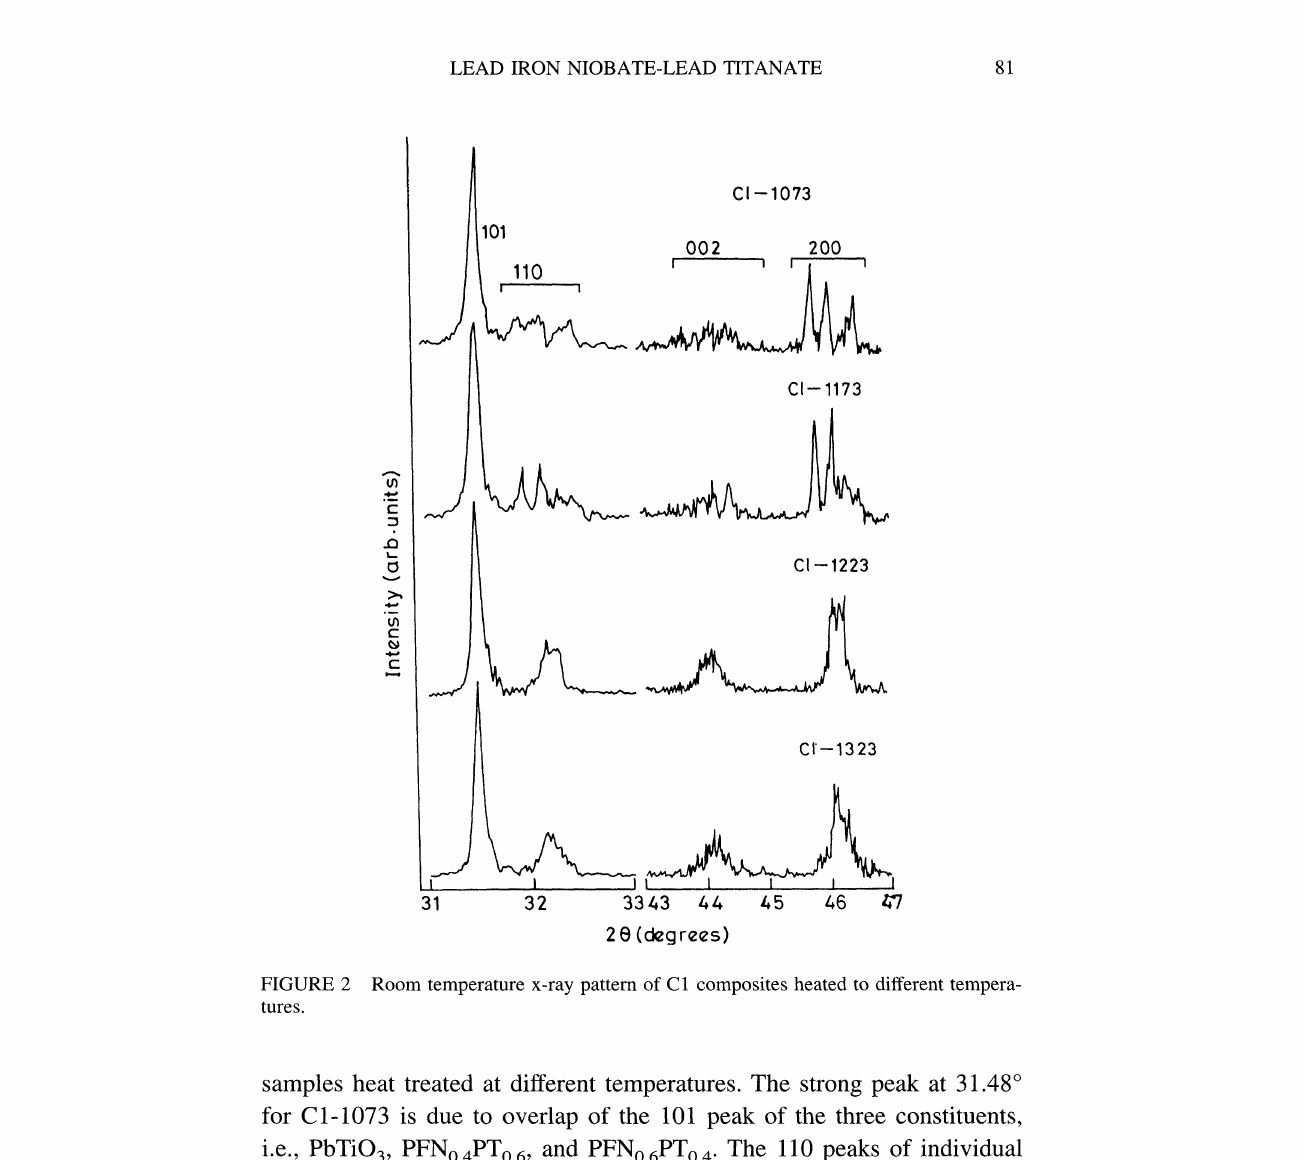
samples heat treated at different temperatures. The strong peak at 31.48 for C1-1073 is due to overlap of the 101 peak of the three constituents, , , PFNo.4PTo.6, and PFNo.6PTo. The 110 peaks of individual i.e., PbTiO 4. 3, respec- phases are observed at a two theta of 31.91 32.12 and 32.42 tively. Similarly, the 200 peaks at 45.80 46.06 and 46.48 are clearly seen for the respective phases. The pattern for C1-1173 shows that 110, 002, and 200 peaks due to PbTiO3 started disappearing on heating to higher temperatures. The pattern for C1-1223 shows a single broad 110 peak and broad peaks corresponding to 002 and 200. The position of these peaks remain the same in C1-1323 except that the peaks become